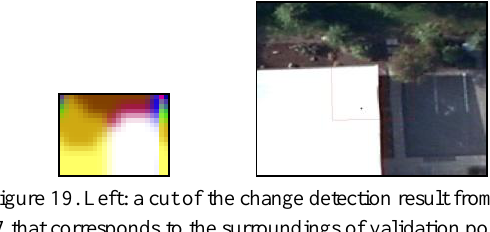
Figure 19. Left: a cut of the change detection result from Figure 7 that corresponds to the surroundings of validation point 6 in Figure 13; right: an aerial photo that covers the region of validation point